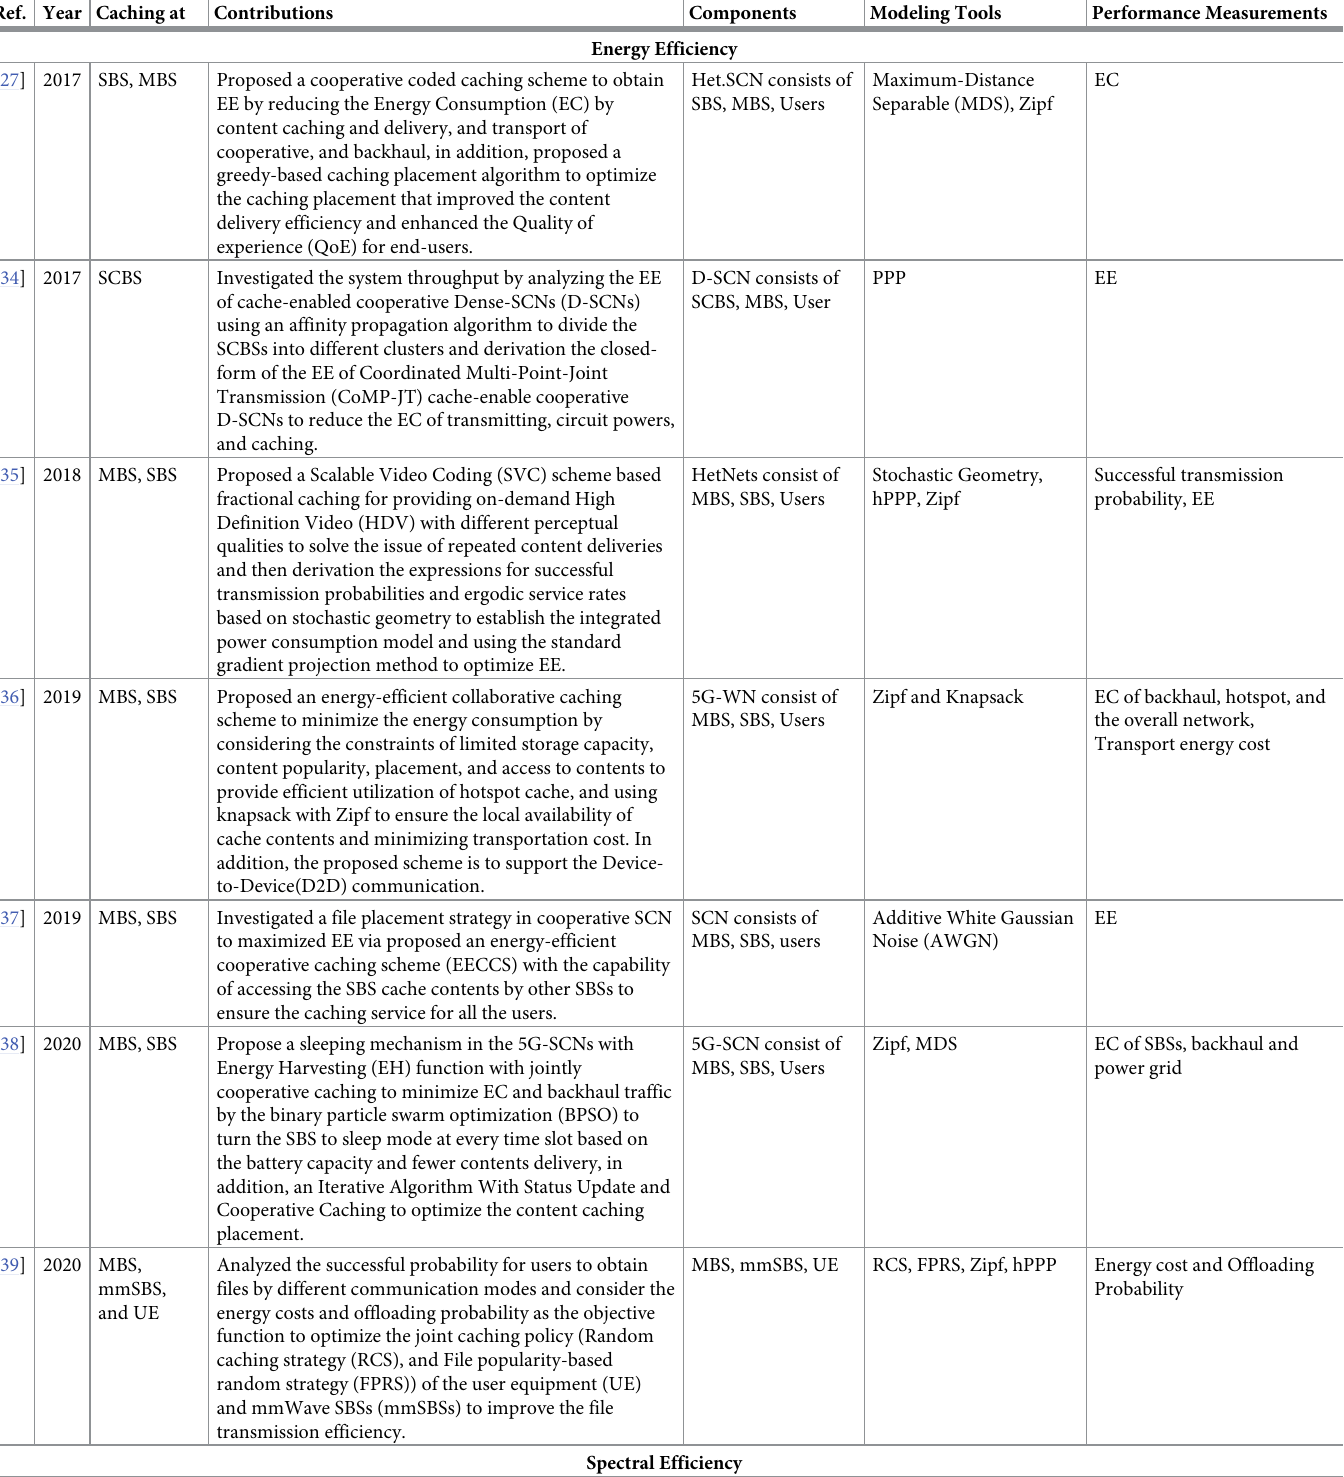
Table 1. Summary of existing works about the impact of cache on energy, spectral and cache efficiencies of SCN. Ref. Year Caching